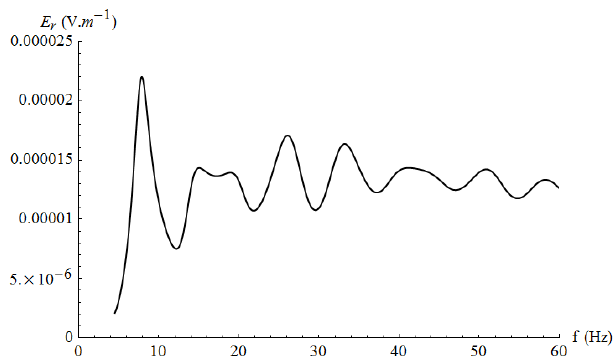
Figure 5: Electric field versus frequency at a distance of 1000 km from the source.